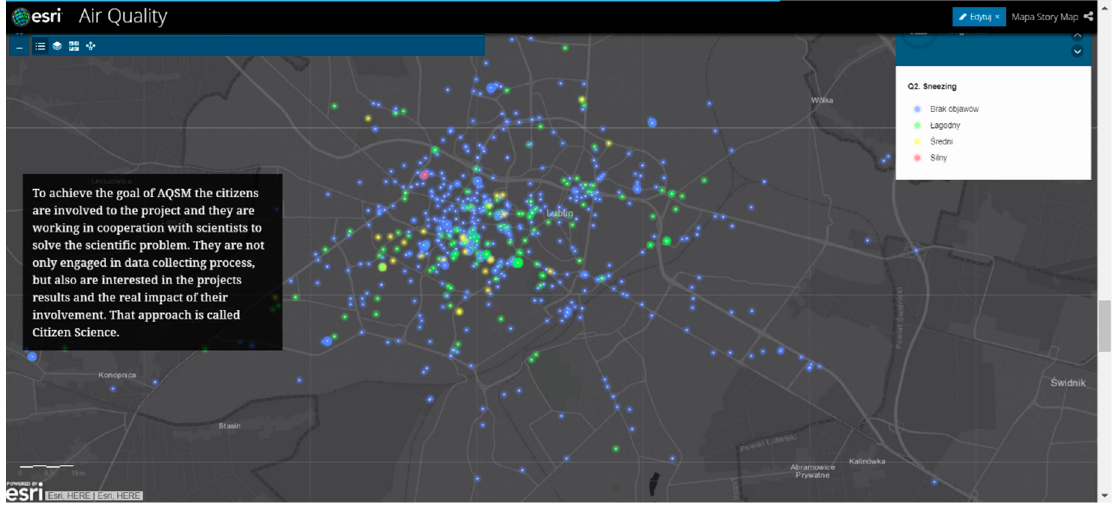
Figure A3. Educational part of the application: cascade story map.